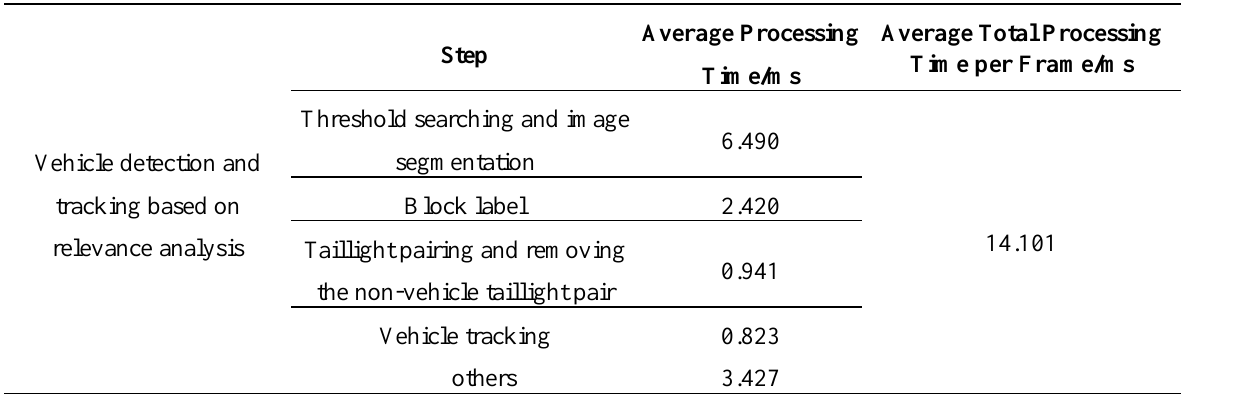
Table 1. Average processing time of the proposed